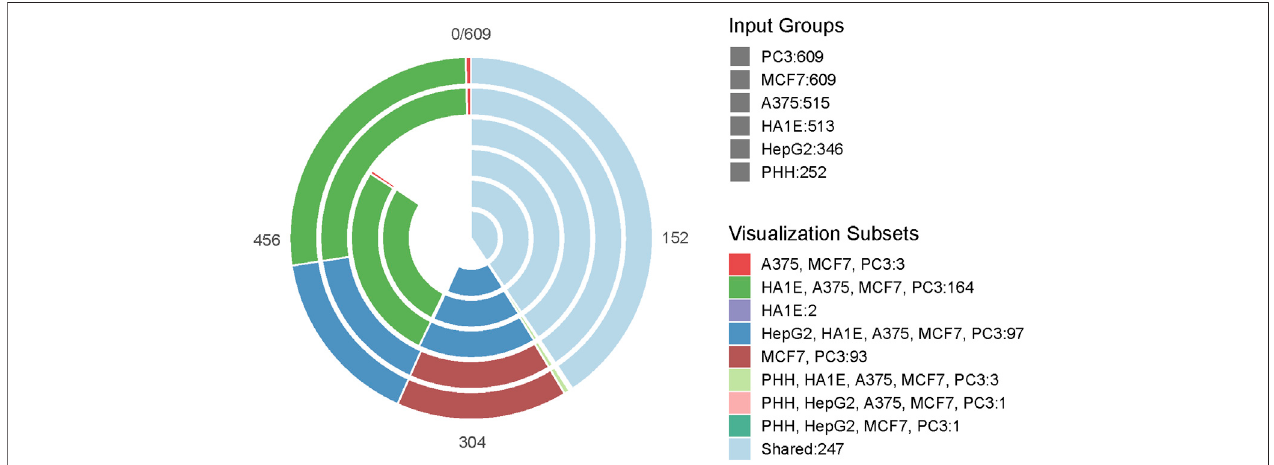
FIGURE 2 | Drug Testing Cell Distribution. The Venn-Pie diagram depicts the overlap of drugs tested between each of the six cell lines used in this study. Each bar within the Venn-Pie represents an individual dataset while the color of the bars indicates the overlapping group of compounds across datasets. While 247 of the 617 drugsincludedinthetrainingandtestdataweretestedinallsixcelllines,somecompoundswereonlytestedinasingularcelllineandothersdidnothaveanyexpression information provided.